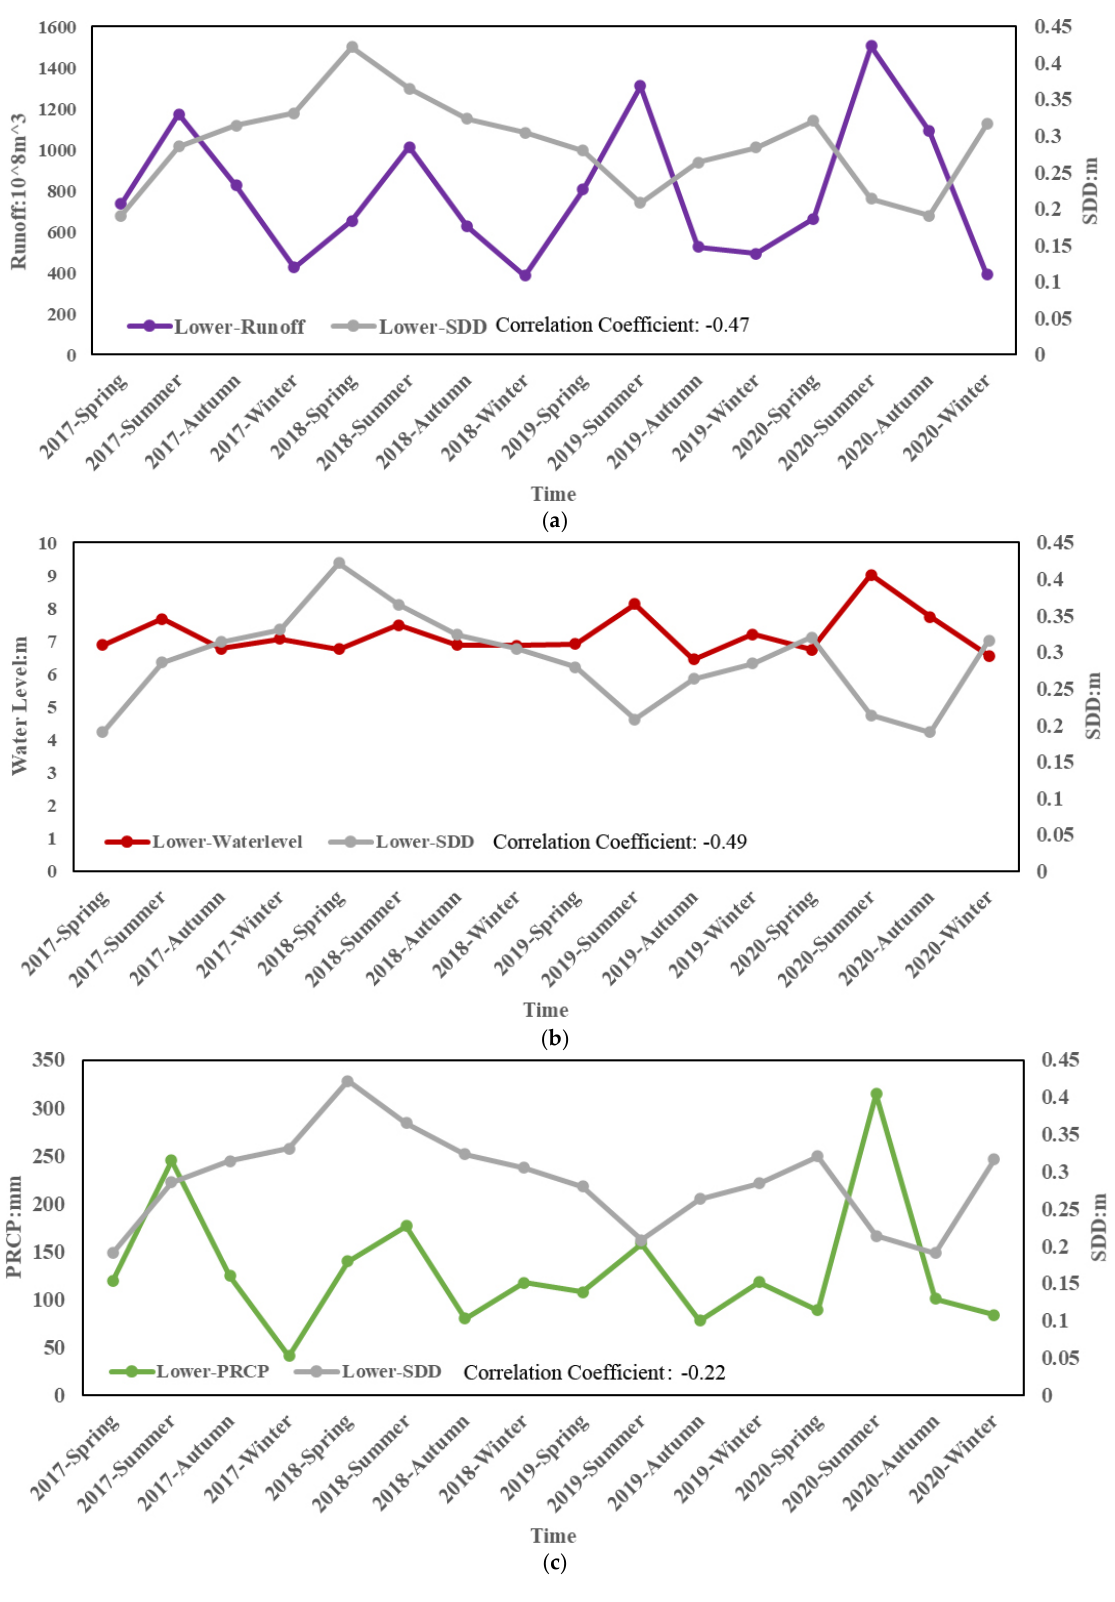
Figure 12. The relationship between the lower reaches of the Yangtze River and runoff, water level, PRCP; ( a ) the relationship between the SDD and runoff; ( b ) the relationship between the SDD and water level; ( c ) the relationship between the SDD and